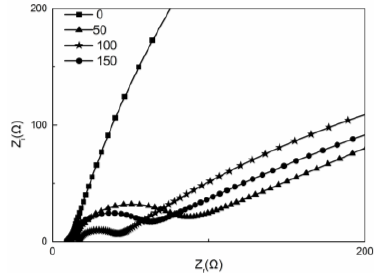
Figure 6. Nyquist plots of electrochemical impedance spectroscopy (EIS) by the Cu oxide-coated carbon cloths with different deposition times. Table 2. Electrochemical impedance fitting results of different cathodes